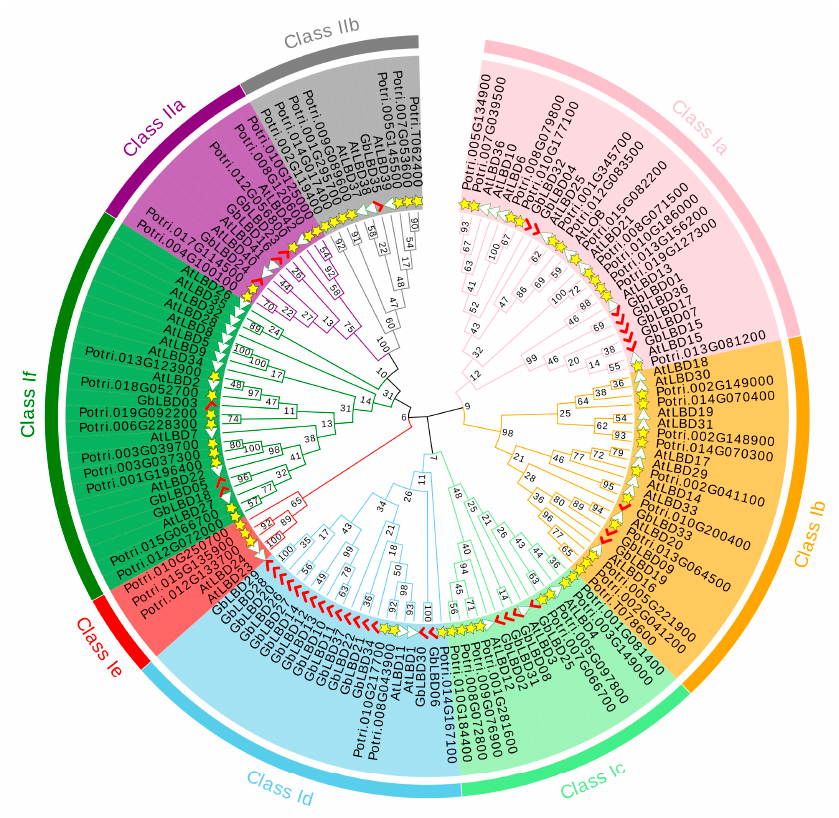
Figure 1. Phylogenetic tree of Lateral organ boundaries domain (LBD) proteins from Ginkgo, Populus, and Arabidopsis. There are eight subclasses in classes Ia-If, IIa and IIb. The red markers, yellow stars and white triangles indicate the LBD proteins in Ginkgo, Populus, and Arabidopsis, respec- tively.